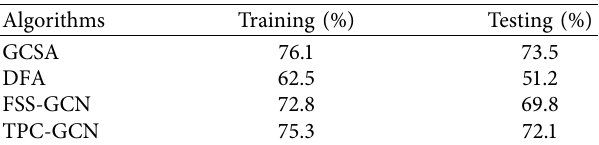
Table 3: Parameters for the proposed algorithm. The pretrained BERT (700d) is chosen as the fixed word embedding Maximal size of neighborhood (connected nodes) is 5 The dropout rate to 0.5 The learning rate to 0.0008 with the Adam optimizer Maximum number of training iterations is 1000 Table 4: The average training and test accuracy obtained from different methods.